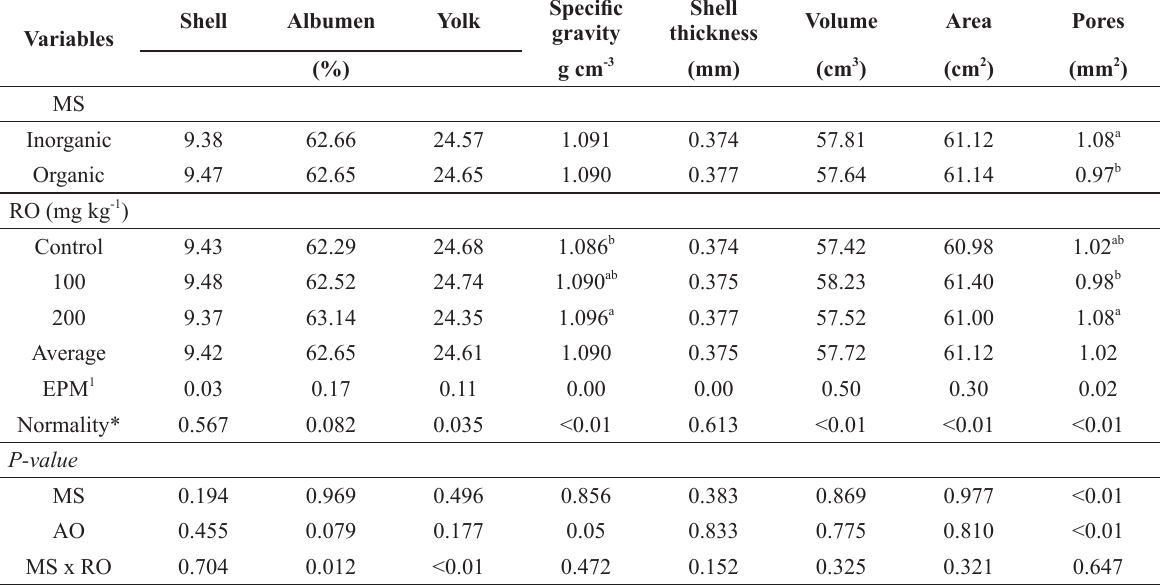
Quality of eggs from red layers fed different mineral sources (MS) and rosemary oil levels (RO).